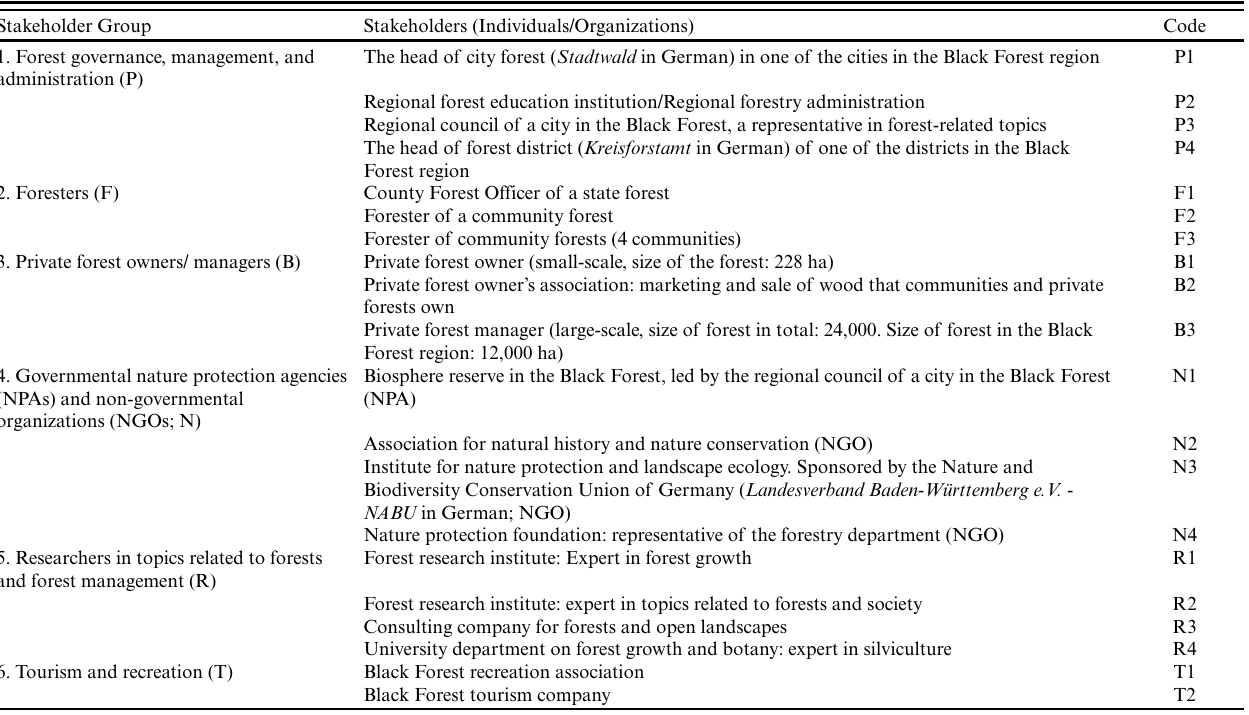
Table 1 . List of the 20 stakeholders